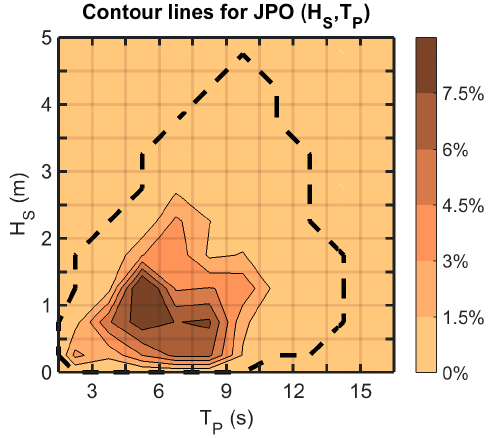
Figure 12. JPO ( H S , T P ) for the Bolt ‐ 2 Lifesaver general wave measurements.